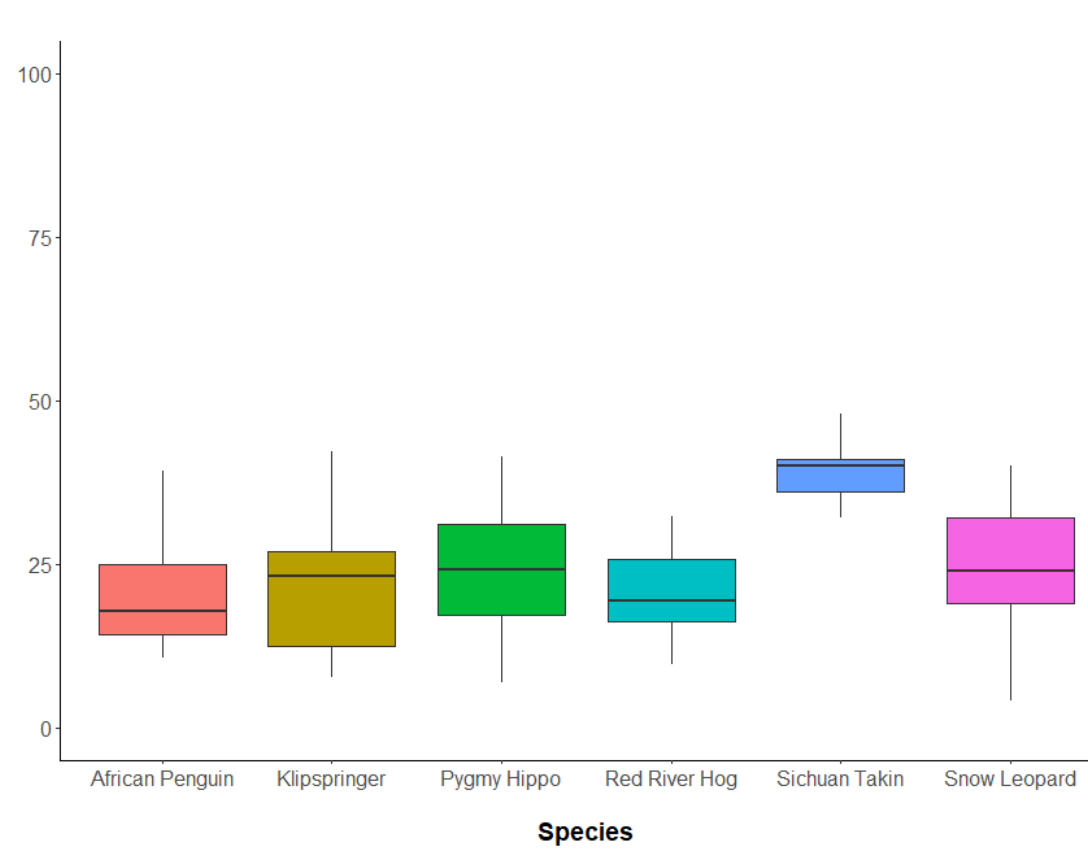
Figure 1. The percent of ethogram behaviors volunteer observers encountered during inter-observer reliability tests for six species monitored as part of a zoo-wide behavior monitoring program. Boxplots depict the median (line), inter-quartile range (box), and min and max values (whiskers).